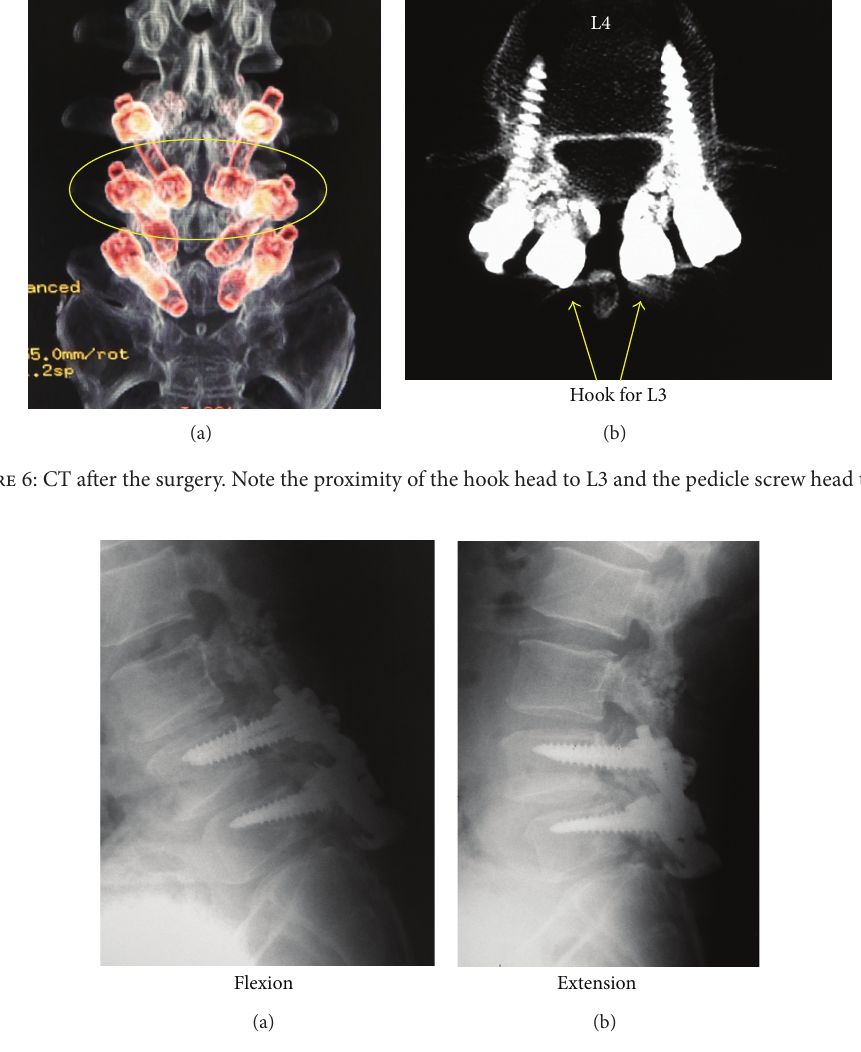
Figure 7: Plain dynamic film after the removal of the L3 systems. Motion is